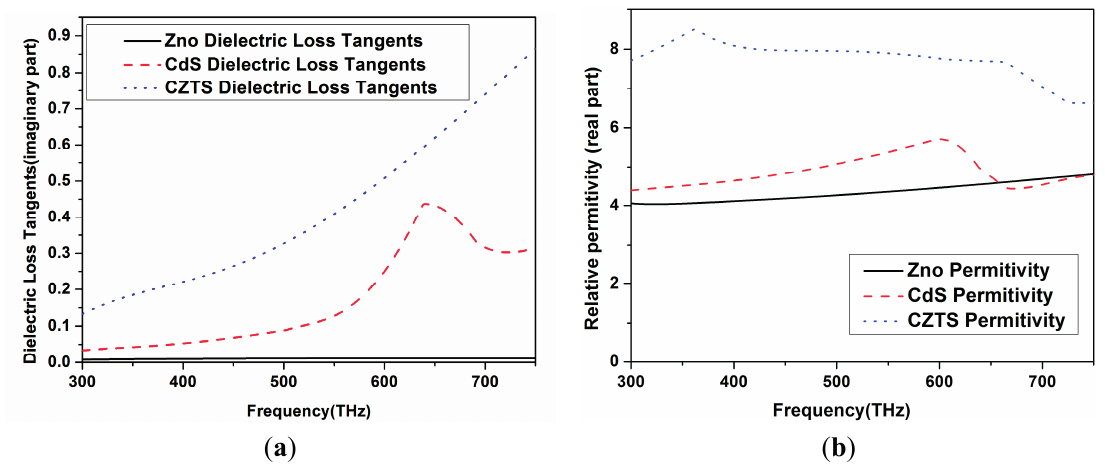
Figure 3. ( a ) Imaginary parts of the dielectric loss tangent. ( b ) Real parts of the relative permittivity of ZnO, CdS, and CZTS layers.